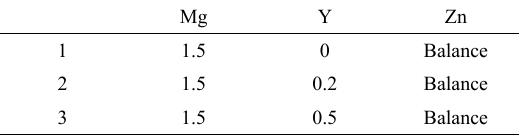
Table 1. The nominal chemical compositions of Zn-1.5Mg-xY alloys in wt% Mg